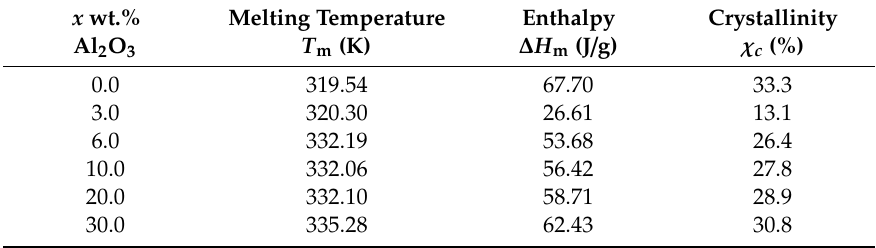
Figure 2. DSC thermograms for (PEO) 10 CF 3 COONa + x wt.% Al 2 O 3 composite ( x = 0.0, 3.0, 6.0, 10.0, 20.0, and 30.0).